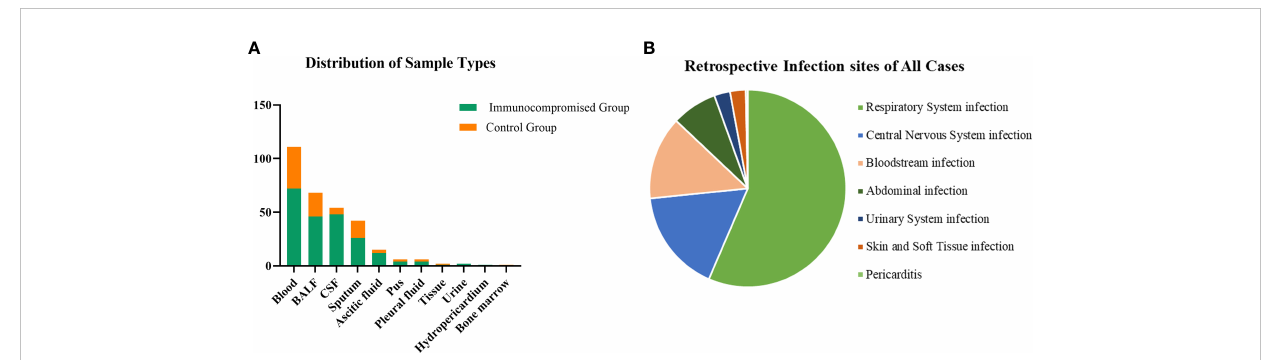
FIGURE 2 The distribution of sample types and infection sites. (A) In samples of this study, 36.0% were from the blood which was the most, 22.1% from BALF, 17.5% from CSF, and the others were from sputum (13.6%), ascitic fl uid (4.9%), pus (1.9%), pleural fl uid (1.9%), tissue (0.6%), urine (0.6%), hydropericardium (0.3%), bone marrow (0.3%). (B) Most infection sites were respiratory system infections (174/308,56.5%) and followed by central nervous system infections (52/308,16.9%), bloodstream infections (42/308, 13.6%), abdominal infections (23/308,7.5%), urinary system infections (8/ 308,2.6%), skin and soft tissue infections (8/308,2.6%), pericarditis (1/308,0.3%). CSF, cerebrospinal fl uid; BALF, bronchoalveolar lavage fl uid.